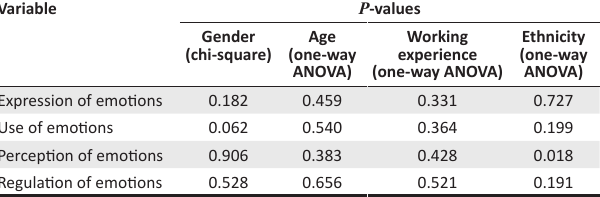
ANOVA, analysis of variance.